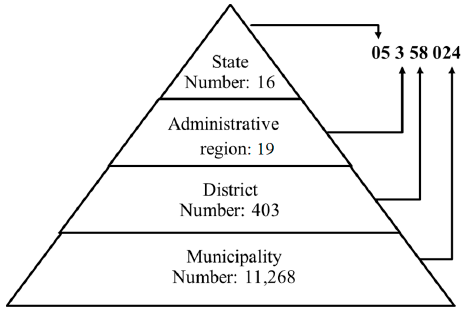
Figure 3. The topology of Germany and the official municipality key for Juelich (North Rhine Westphalia).